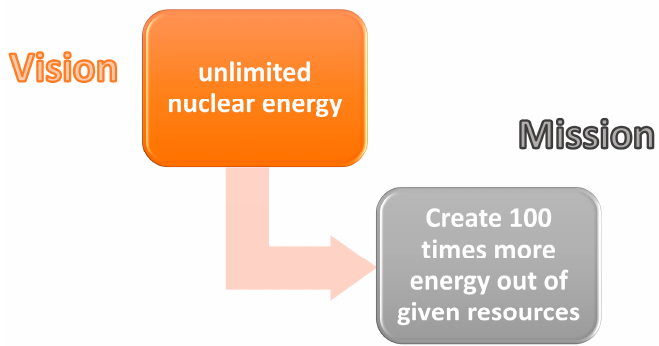
Figure 5. Translating the vision of unlimited nuclear energy into a viable mission.